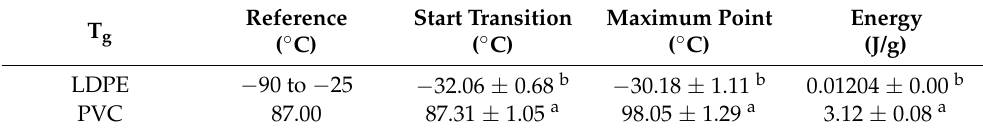
Table 4. Experimental glass temperature (T g ) of the films. T g